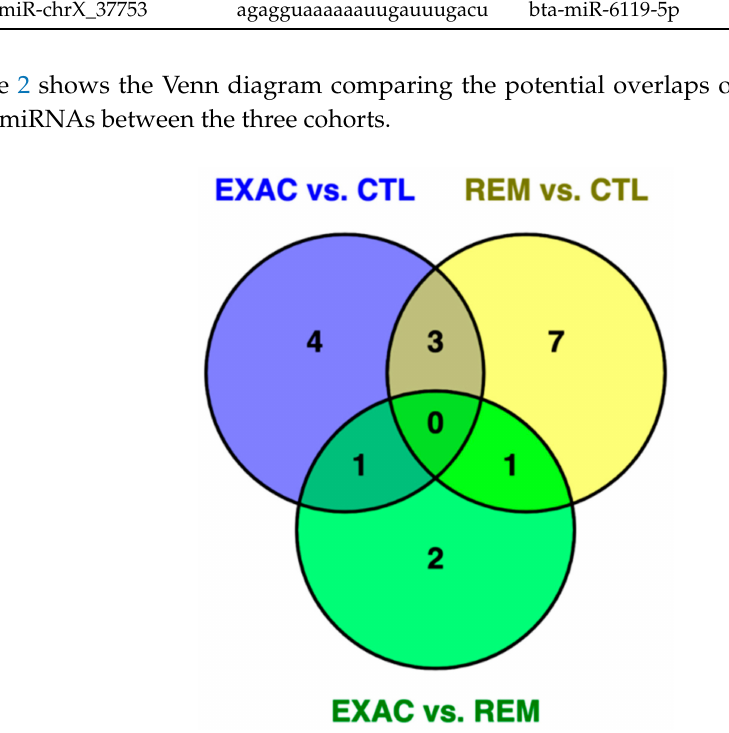
Figure 2. Venn diagram of di ff erentially expressed miRNAs of the three comparisons: exacerbation (EXAC) vs. control (CTL), remission (REM) vs. CTL, and EXAC vs. REM. Shared between EXAC vs. CTL and EXAC vs. REM was eca-miR-31, while eca-miR-NW_019643269.1_38788 was shared between REM vs. CTL and EXAC vs. REM. Three miRNAs were shared by two comparisons (exacerbation vs. control and remission vs. control): eca-miR-142-3p, eca-miR-142-5p, and